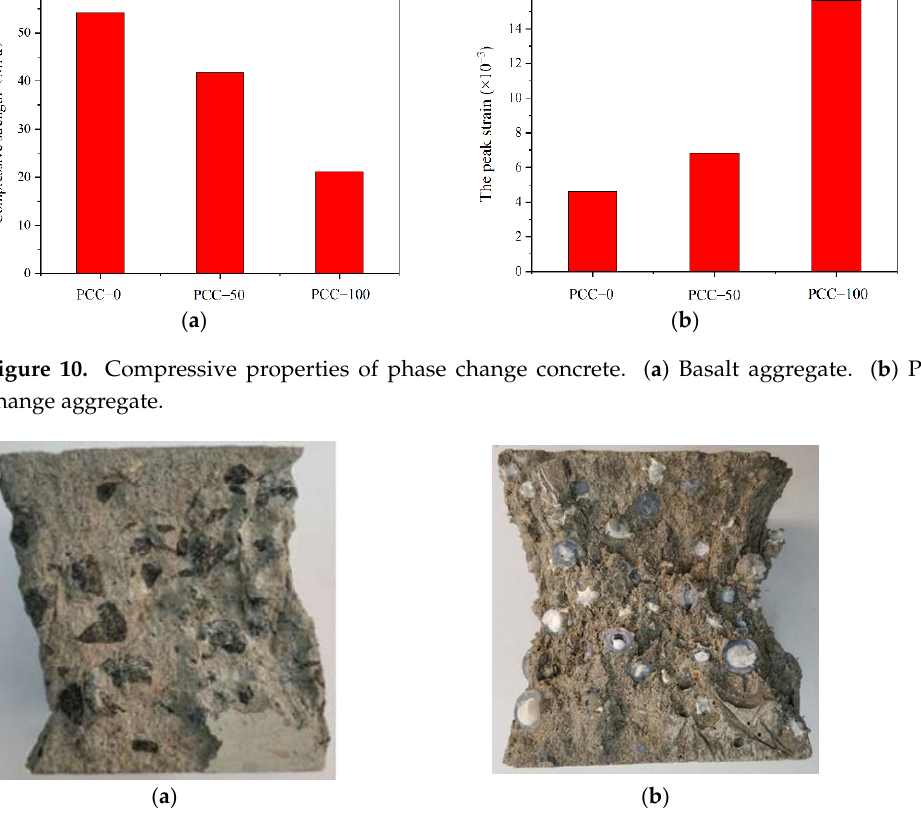
Figure 11. Damage condition of concrete with different aggregates. ( a ) Basalt aggregate. ( b ) Phase change aggregate.